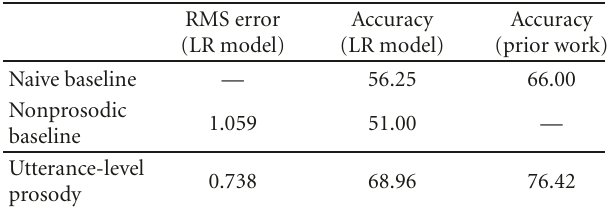
Table 4: Our basic prosody model uses utterance-level prosodic features to fit a linear regression (LR) model. This set of input variables performs significantly better than a linear regression model trained on nonprosodic features, as well as the naive baseline of choosing the most common class. The improvement over this naive baseline is on par with prior